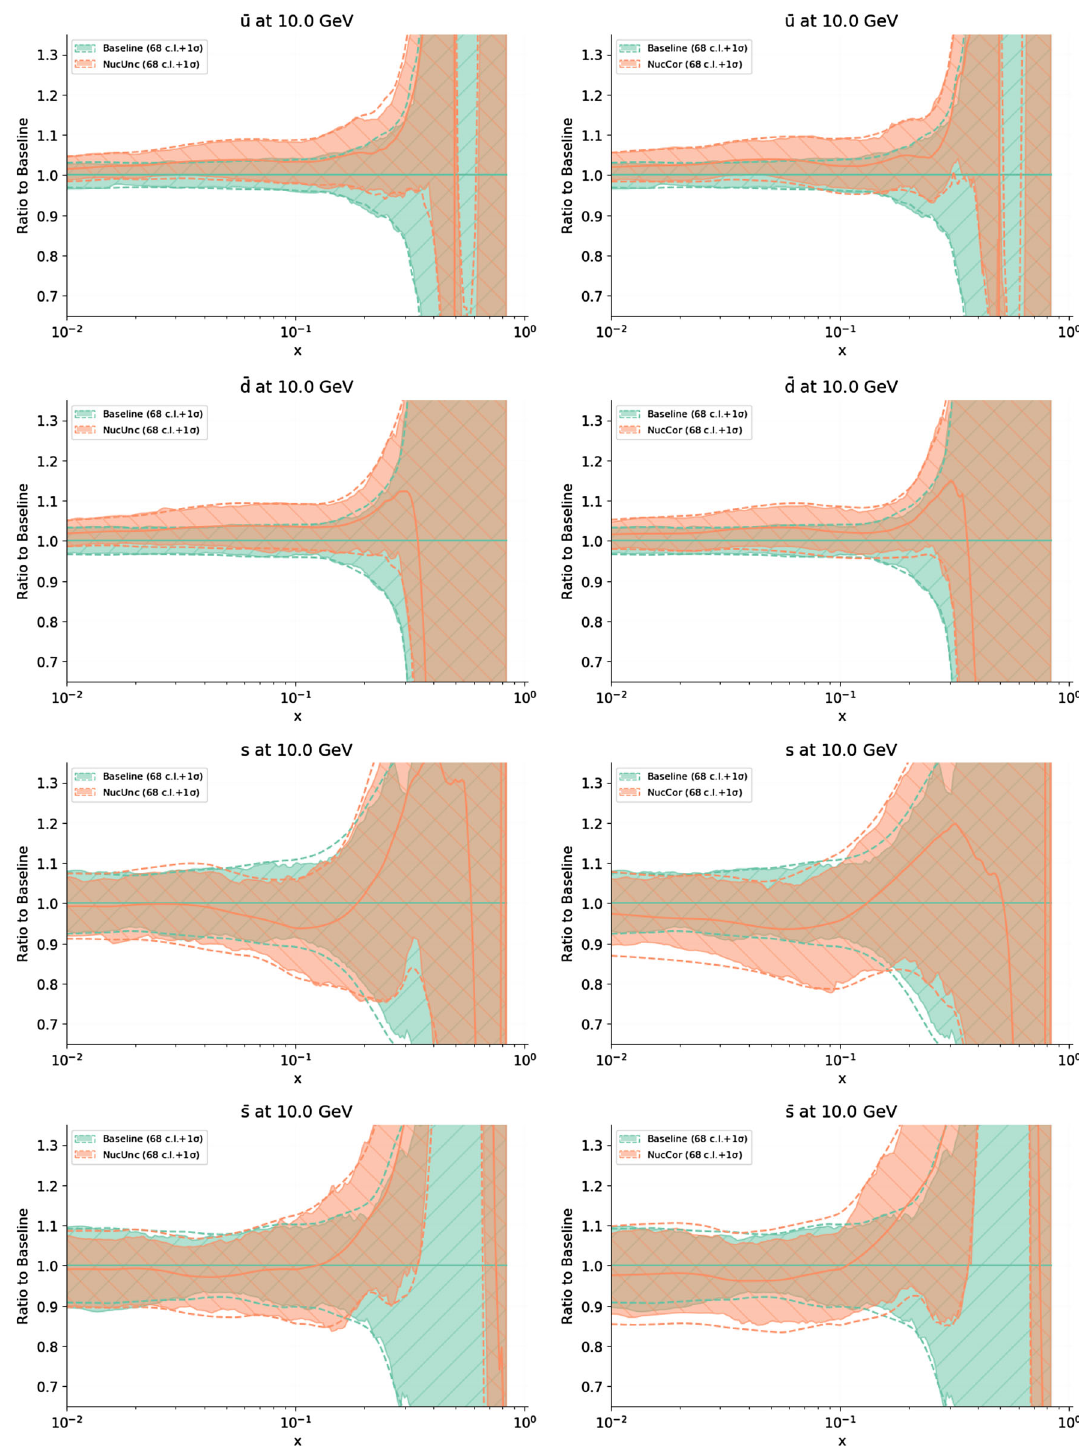
Fig. 11 Comparison between the Baseline fit, and each fit including theoretical uncertainties, NucUnc (left), and NucCor (right). The antiup, antidown, strange and antistrange flavours are shown at Q = 10 GeV from top to bottom. Results are normalised to the Baseline